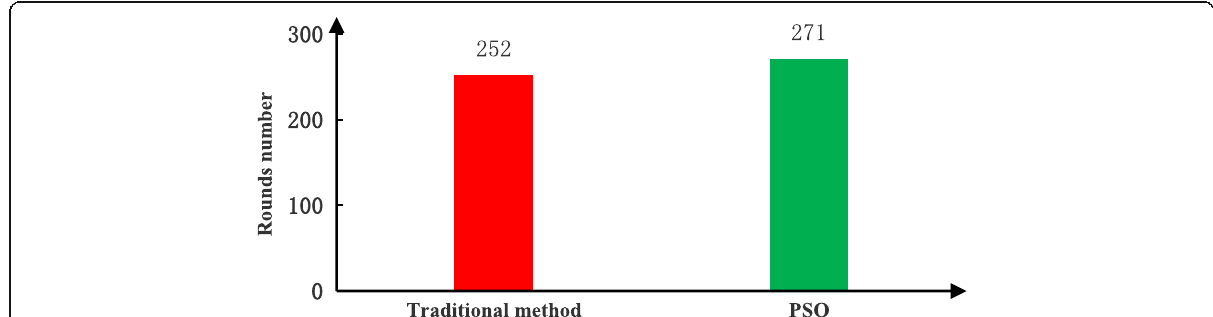
Fig. 9 Comparison of network lifetime. This figure shows the comparison of the performance in term of the network lifetime. It can be seen that there is little difference in the lifetime of the network, although the network constructed by the PSO algorithm consumes less energy in one round than traditional method